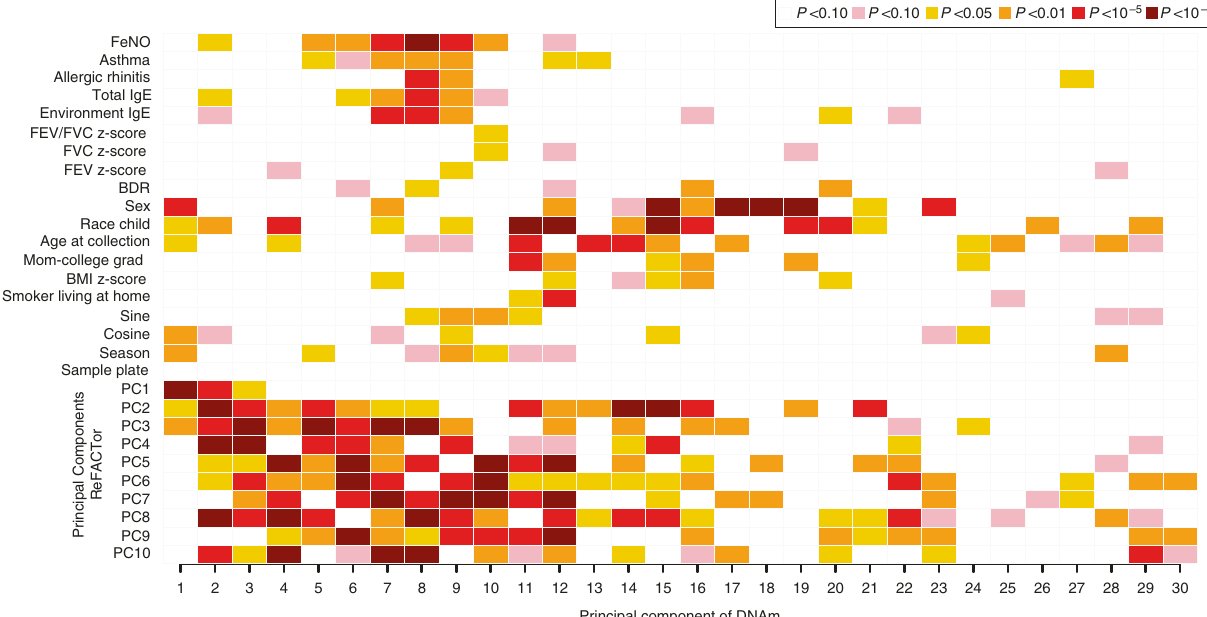
Fig. 1 Associations with Global Nasal DNA methylation (DNAm) variability. Principal component (PC) regression analysis showing univariate association P values color-coded by smallest P value (dark red; P < 10 − 10 ) to largest (blank; P > 0.10) between all covariates of interest and the top 30 PCs explaining 59% of the variance of the nasal DNA methylation data in the x -axis. PCs 1 – 10 on the y -axis re fl ect DNAm heterogeneity and differences in cell types bioinformatically estimated using ReFACTor